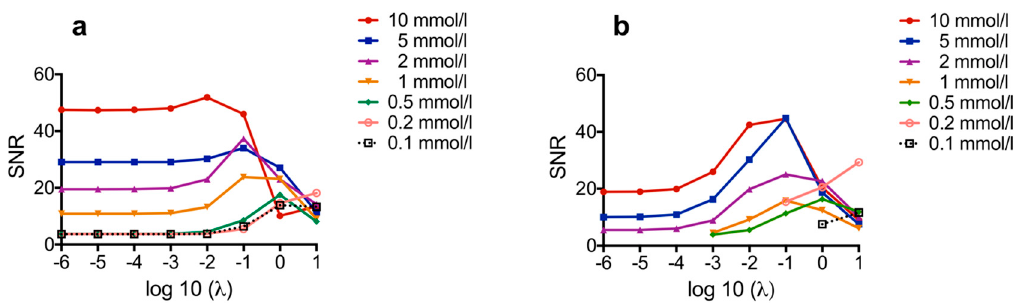
Figure 7. Signal-to-noise ratio (SNR) plotted over λ for MCP 3 ( a ) and Resovist ® ( b ). For reconstruction of the tube phantoms, the λ -values with the highest corresponding SNR for each tracer concentration were used, which were in the range of 10 − 1 to 10 − 2 .